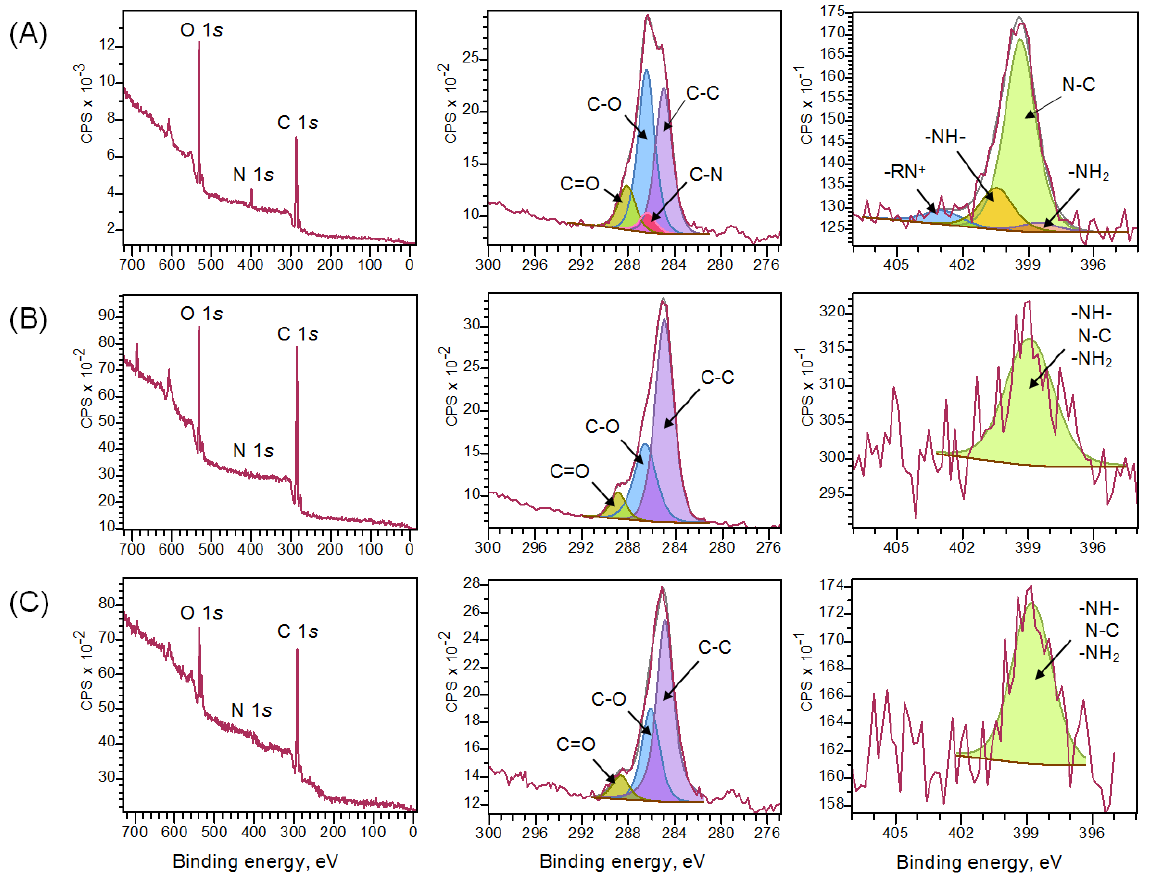
Figure 3. Survey scan, C 1s and N 1s core-level XPS spectra of the original chitosan aerogel ( A ), chitosan aerogel modified with poly(GMA-co-TDMA) copolymers ( B ), chitosan aerogel modified with poly(GMA-co-TDMA) copolymer and diethylamine ( C ). Table 3. Results of elemental analysis of the surface of chitosan aerogels before and after the modification obtained by the XPS method.